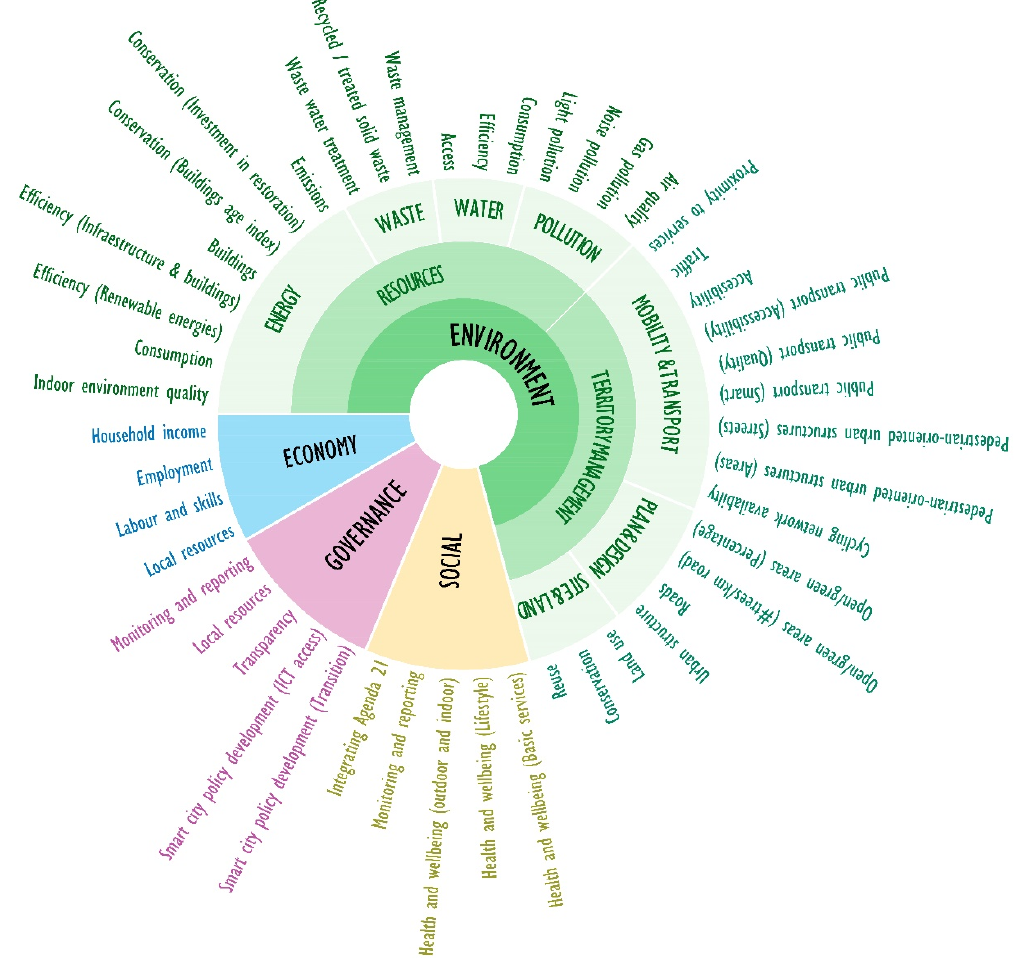
Figure 4. Proposed structure for areas, categories and subcategories.